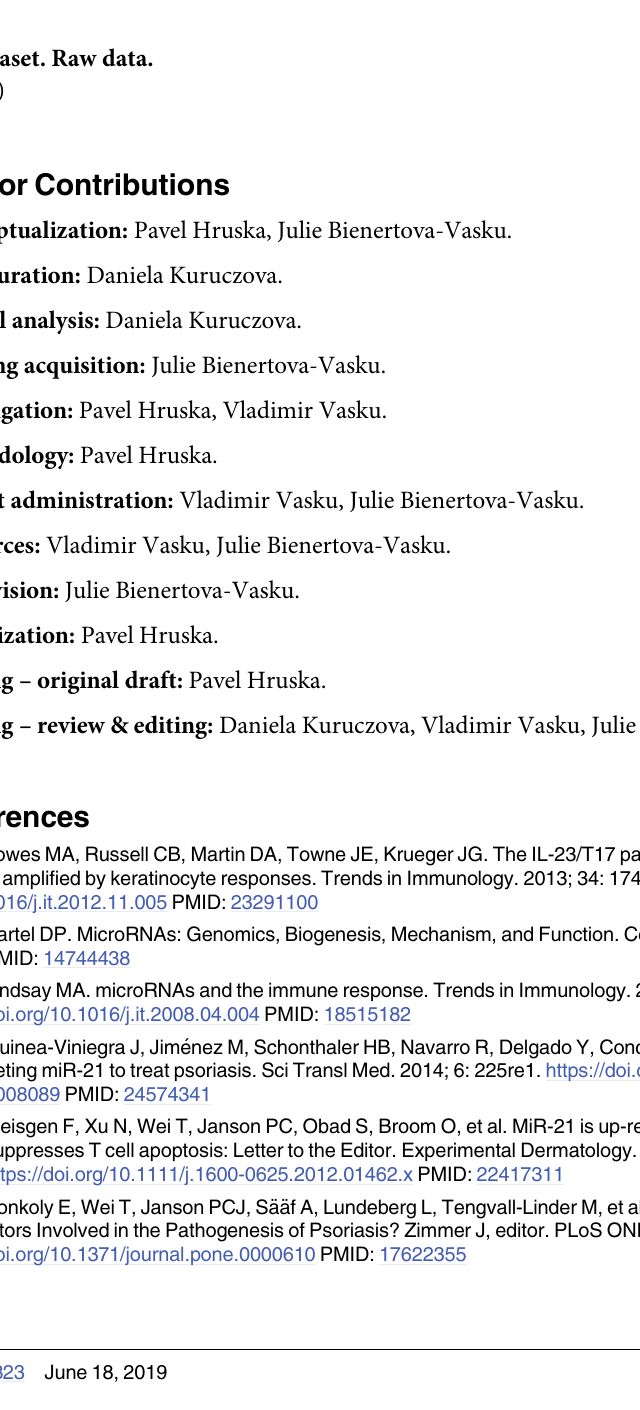
S1 Table. SNP characteristics. S2 Table. SNP analysis of psoriasis subtypes. S3 Table. Early and late onset psoriasis SNP association